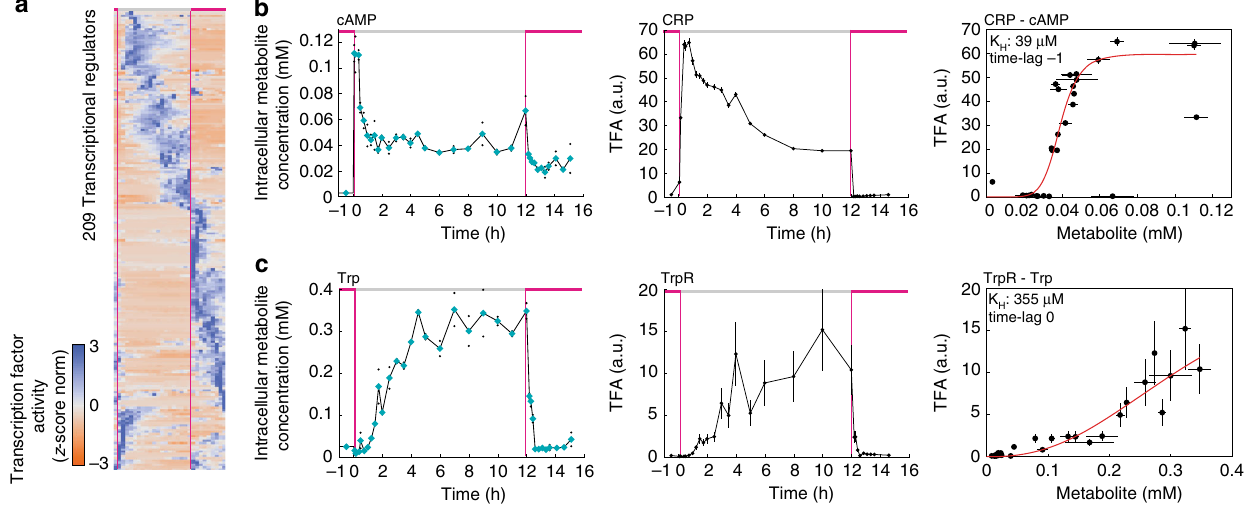
Fig. 3 Metabolite levels and transcription factor activities recover regulatory interactions. a Z-score normalized activity of 209 transcriptional regulators. Blue indicates high activity; orange indicates low activity. Activity was estimated from the transcriptome data with network component analysis (NCA). b Dynamics of cyclic-AMP concentration (left) and CRP activity (middle) during the growth – starvation-growth switch. Correlation of cyclic-AMP and CRP activity (right). The red line is the best fi t of a Hill function ( K H = 39 µ M). The correlation is shown with a time-lag of one data point to account for a time- delay between activity changes of CRP and changes in gene expression. c Same correlation analysis as in ( b ) for tryptophan (Trp) and the activity of TrpR, the repressor of the tryptophan operon. For cAMP and tryptophan, black dots show two replicates per time point, and colored dots are the mean. Error bars of transcription factor activity indicate the 95% con fi dence interval of n = 100 randomized estimates with NCA. Source data are provided as a